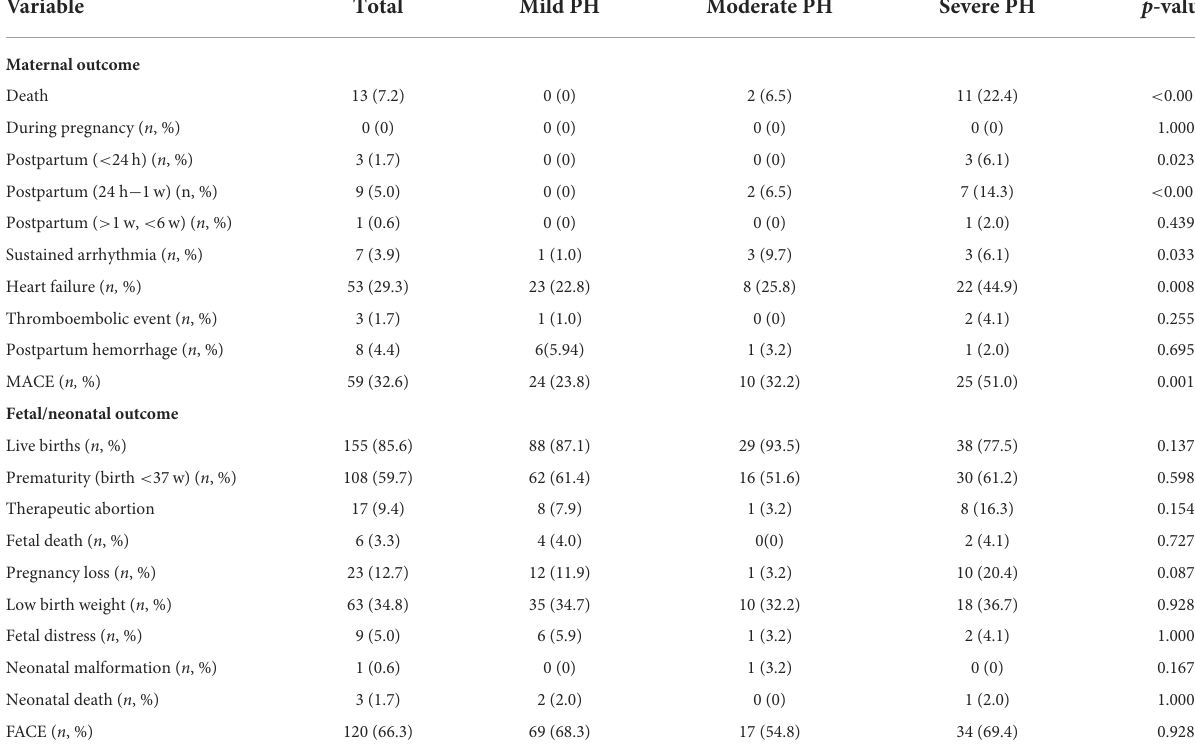
TABLE 3 Maternal and fetal/neonatal outcomes of women with PH diagnosed via echocardiography. Variable Total Mild